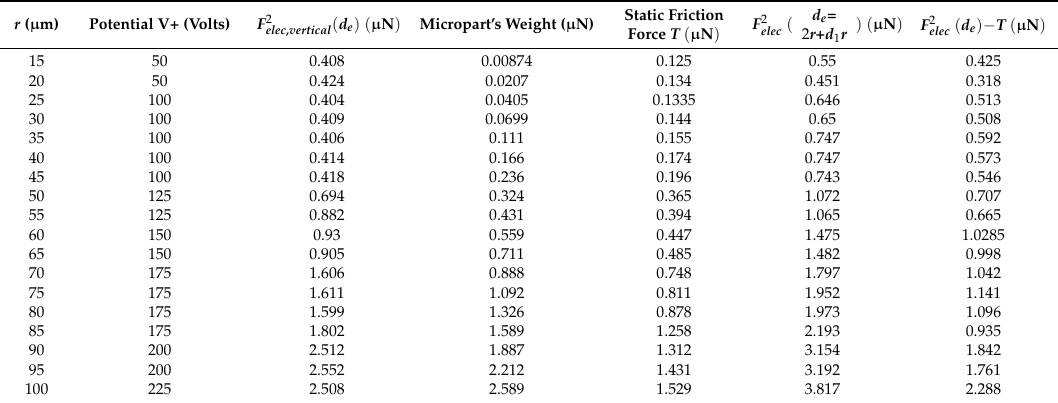
Table 1. Finite Elements Method (F.E.M.) measurements and computations of the Forces applied to rectangular microparts of different sizes (the three significant digits are